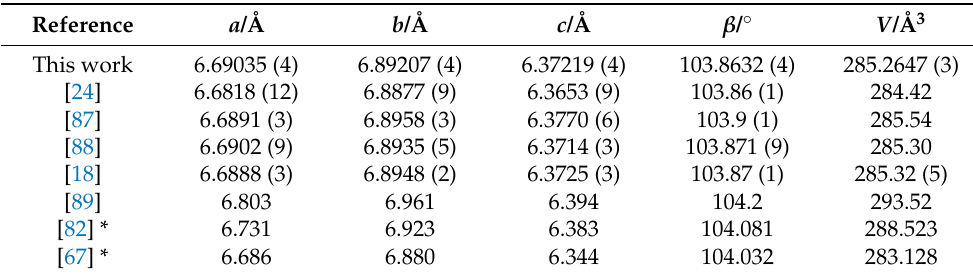
Table 2. Structural data of monazite-type SmPO 4 obtained by Rietveld refinement compared to selected published crystal data.